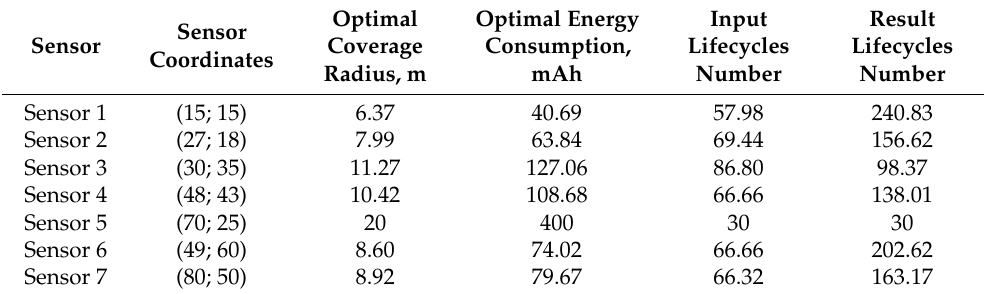
Table 3. Result sensors’ parameters.